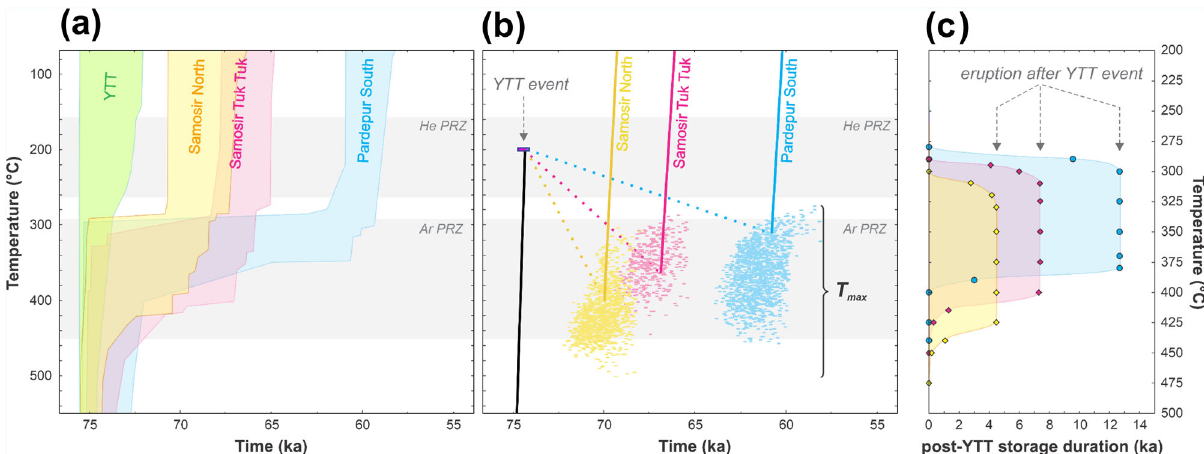
Fig. 4 Thermal history modelling highlighting different aspects of time − temperature information extracted from combined inversion of Ar and ZHe thermochronology data. a Time − temperature (tT) diagram showing “ simple cooling ” scenario results that are displayed as tT envelopes of “ good fi t ” tT trajectories (with the goodness of fi t values ≥ 0.5). Note that with exception of YTT sample, all three post-climactic dome samples require a slower cooling phase in order to produce the discordance between their Ar and ZHe ages. b tT diagram showing a “ reheating ” scenario that constrains the minimum and maximum temperature during “ cold storage ” . The results are displayed as in fl ection points of “ good fi t ” tT trajectories. c tT diagram showing the ranges of post-YTT “ cold ” storage duration modelled for different temperatures. Values calculated for different temperatures (the point clouds) can be found in Supplementary Data 4 (full modelling parameters in Supplementary Note 3; Supplementary Figs. 3, 4).